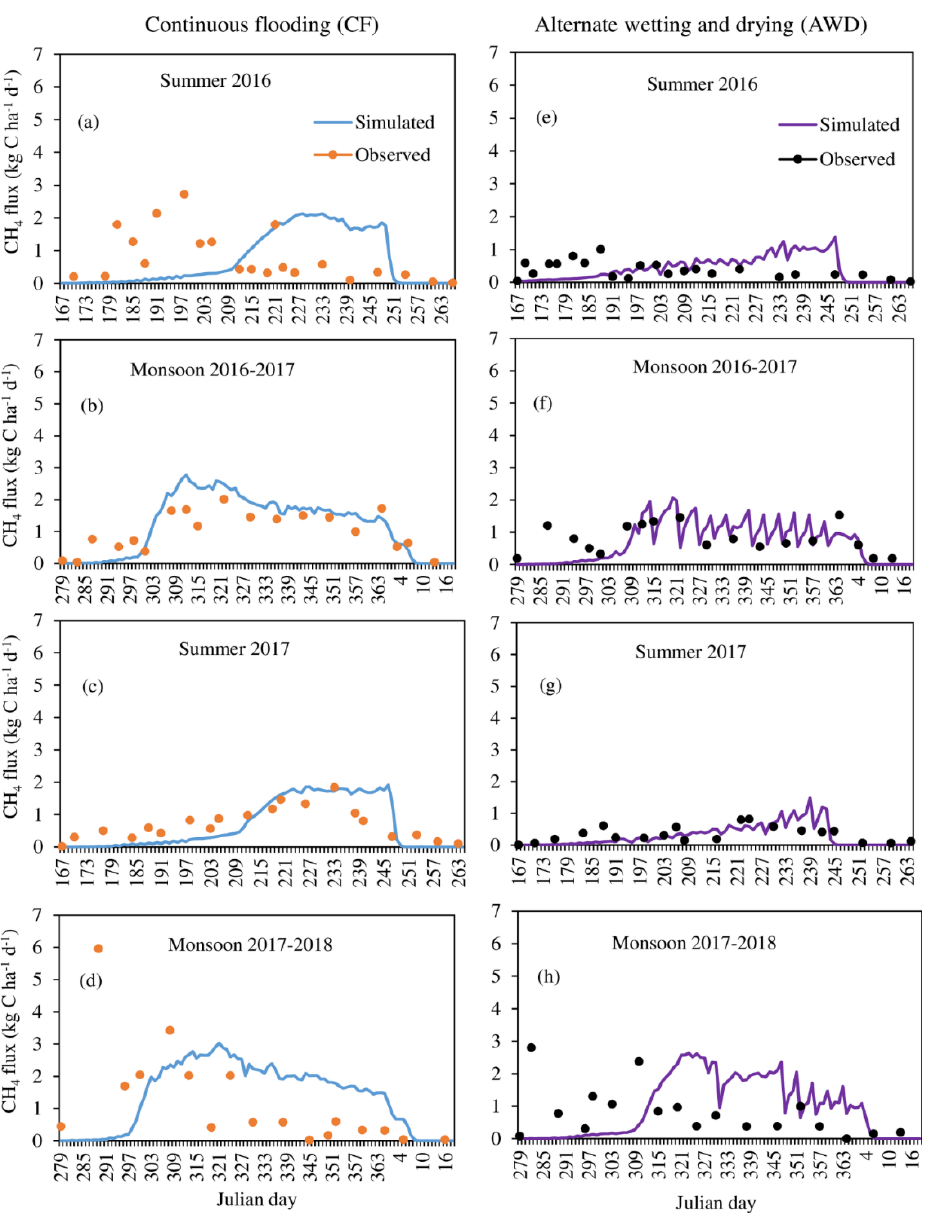
Figure 3. Observed and simulated CH 4 emissions from rice fields under continuous flooding ( a – d ) and alternate wetting and drying conditions ( e – h ) during different rice-growing seasons.